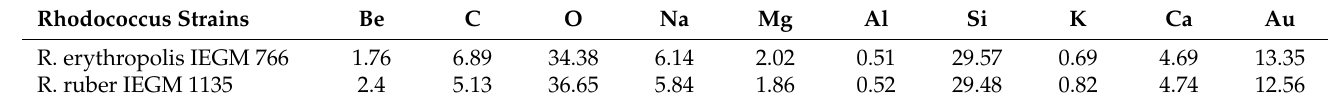
Table 1. Elemental composition (%) of the SEM preparations with biosynthesized AuNPs. Rhodococcus Strains